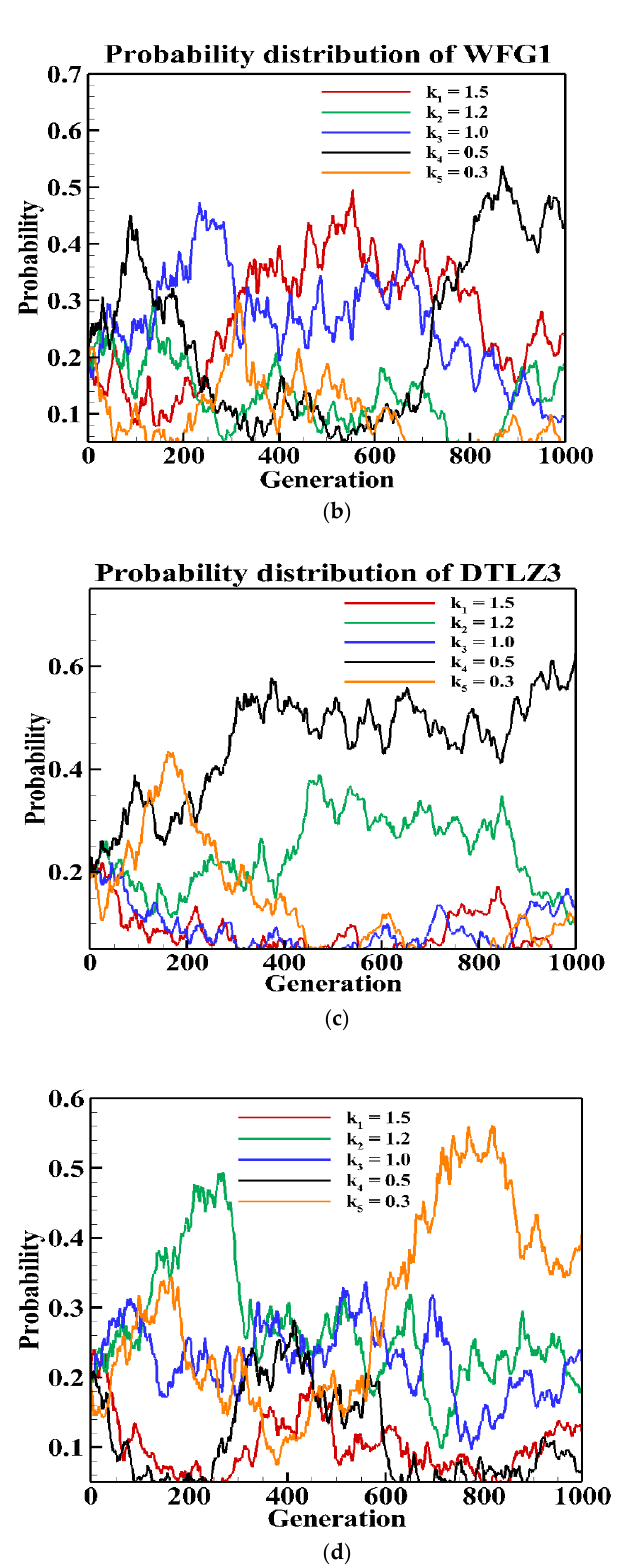
Figure 5. Probability of parameters during evolution on 4- and 8-objective DTLZ3 and